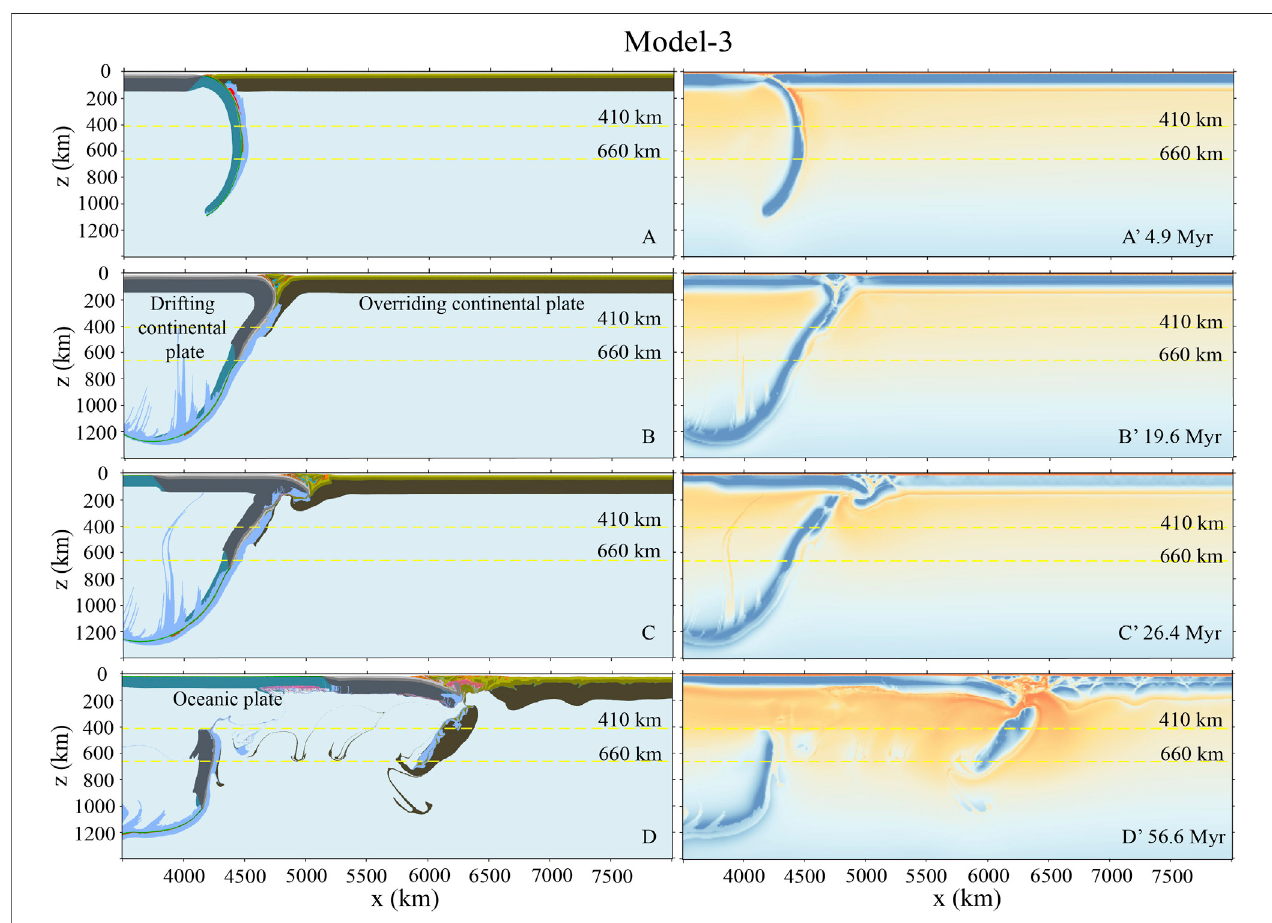
FIGURE 5 | Model-3 evolution with a further decreased plastic friction coef fi cient of the overriding lithospheric mantle, which is initially λ · sin ( φ ) (cid:2) 0.1 and will decrease linearly to 0.01 with the accumulated plastic strain to ε plas = 1 ( Supplementary Table S2 and Supplementary Equation S11 in the supporting information). All the other parameters are identical to Model-2 ( Figure 4 ). (A – D) The composition fi eld evolution with the corresponding colorbar is shown in Figure 2A . (A ’ – D ’ ) The effective viscosity evolution with the corresponding colorbar is shown in Figure 2B .